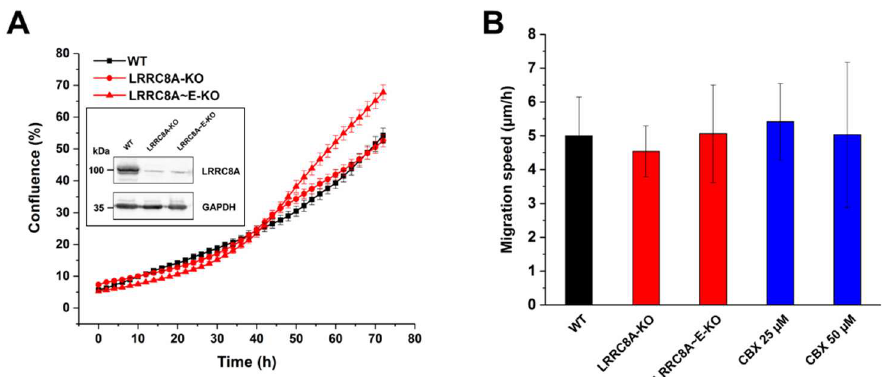
Figure 2. Effect of LRRC8 subunit knockout or carbenoxolone (CBX) treatment on cell proliferation and migration of HCT116 cells. ( A ) Growth curve of wild-type (WT), LRRC8A-knockout (KO), and LRRC8A~E-knockout (KO) HCT116 cells. Data represent mean ± SD of n = 6–9 experiments. Inset: Knockout of the LRRC8A subunit was confirmed by Western blotting. ( B ) Effect of LRRC8 subunits knockout or treatment with CBX on migration of HCT116 cells. Cell migration speed was determined 24 h post-wounding. Data represent mean ± SD of n = 7 experiments.